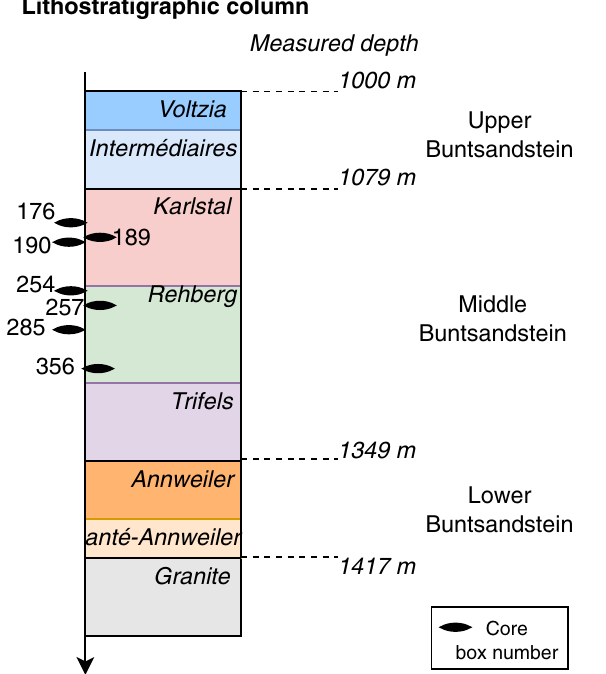
Fig. 2 Lithostratigraphic column for Buntsandstein in exploration borehole EPS-1 (Soultz-sous-Forêts) showing the location of the sampling depths (black ellipses). The box number is given next to each sampling depth (176, 189, 190, 254, 257, 285, and 356). Depths and unit names provided by Aichholzer et al.